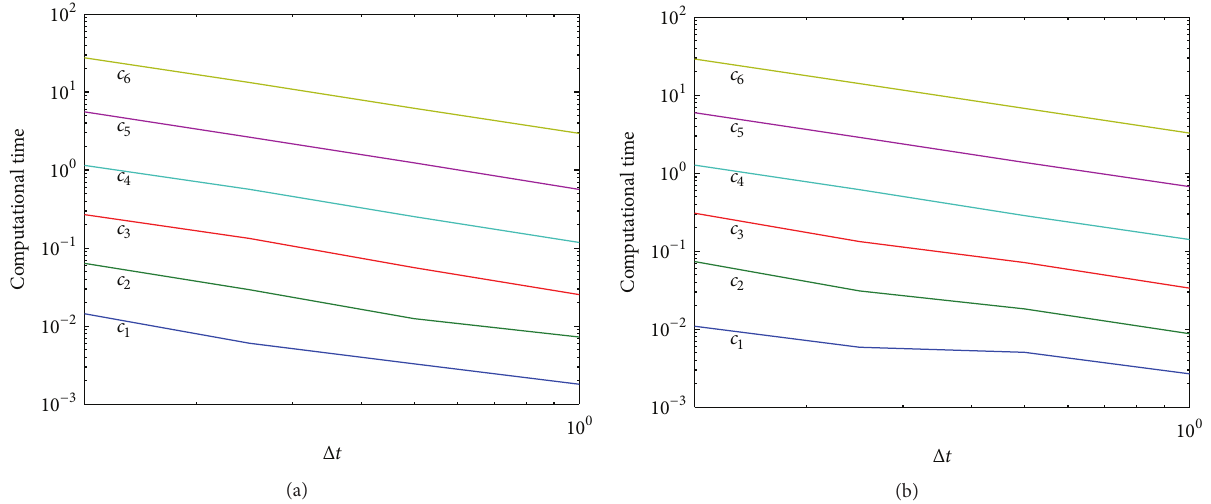
Figure 8: The computational time of the one-sided and two-sided splitting schemes: one-sided splitting over 𝐴 (a) and two-sided splitting scheme alternating between 𝐴 and 𝐵 (b) with 1,. . . , 6 iterative